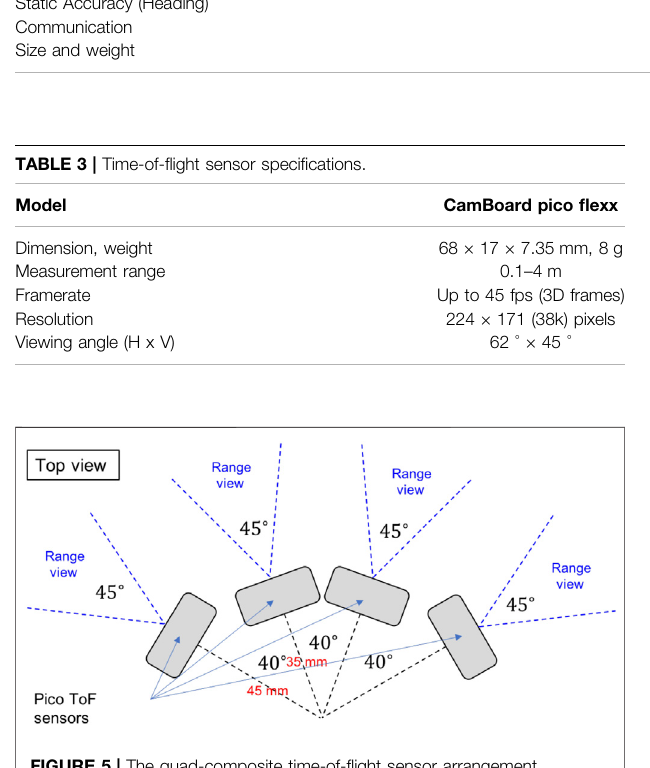
FIGURE 5 | The quad-composite time-of- fl ight sensor